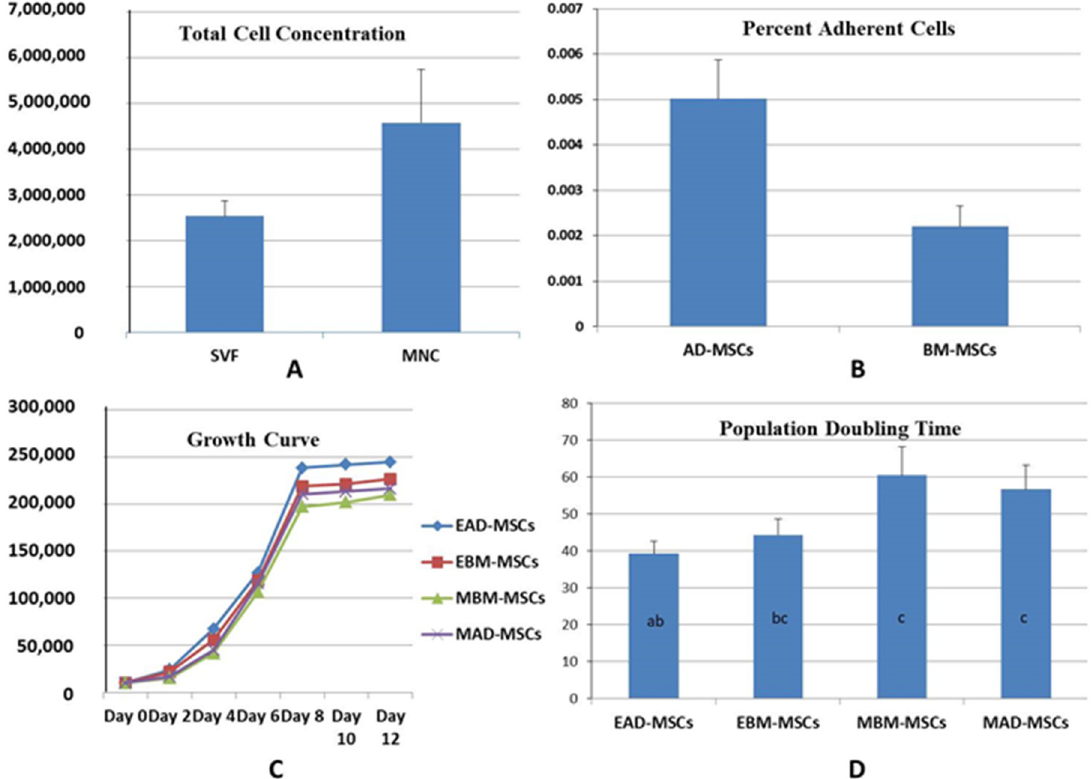
Figure 1. ( A ) The total initial cell concentration harvested from adipose tissue and the bone marrow. Values represented as mean ± SE. ( B ) Percent adherent cells (PAC) from stromal vascular fraction (SVF) and mononuclear cell (MNC) fraction. Values represented as mean ± SE. ( C ) Growth curve of the female adipose tissue MSCs (EAD-MSCs) and bone marrow MSCs (EBM-MSCs), and male sheep adipose tissue MSCs (MAD-MSCs) and bone marrow MSCs (MBM-MSCs). Female AD-MSCs and BM-MSCs had higher proliferation potential. ( D ) Population doubling time (PDT in hours) of the female adipose tissue MSCs (EAD-MSCs) and bone marrow MSCs (EBM-MSCs), and male sheep adipose tissue MSCs (MAD-MSCs) and bone marrow MSCs (MBM-MSCs). Female sheep AD-MSCs had a significantly ( p < 0.05) lower PDT as compared to the other cell types. Bars with different letters differ